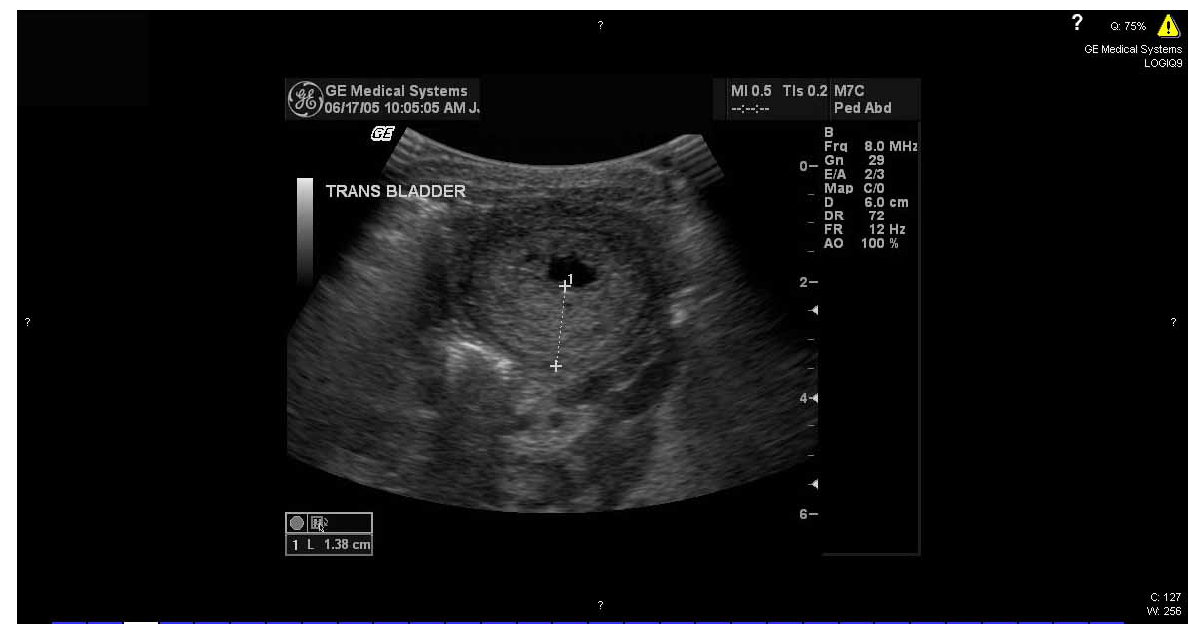
FIGURE 6A . Postnatal bladder ultrasound demonstrating a thickened bladder secondary to bladder outlet obstruction from posterior urethral valves.